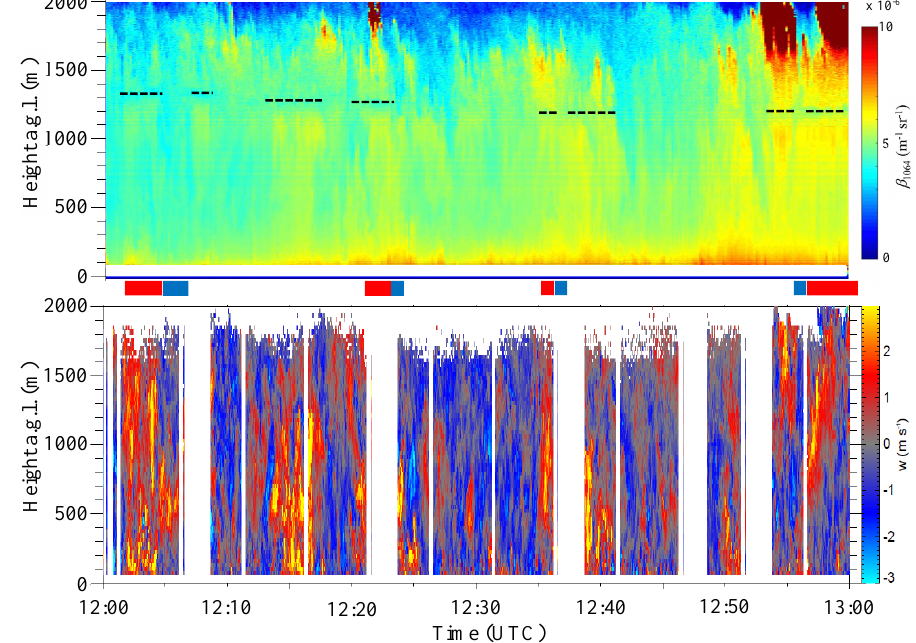
Figure 2. Time–height cross-section of β 1064 (a) and the vertical wind speed (b) in the time interval 12:00–13:00UTC on 18 April 2013. The black dashed line in panel (a) around 1200m highlights the presence of a persistent lidar backscatter reduction (clear-air dark band), with alternating intensity fluctuations. The red and blue areas in between the two plots indicate the up-draught and down-draught time intervals, respectively, identified in Fig.